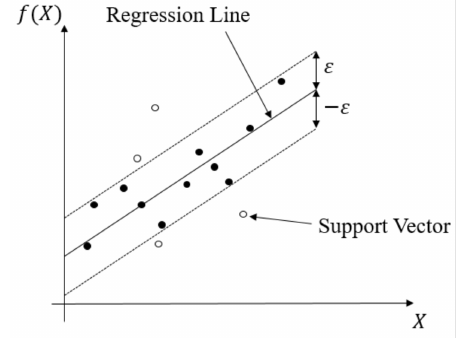
Figure 11. Schematic diagram of